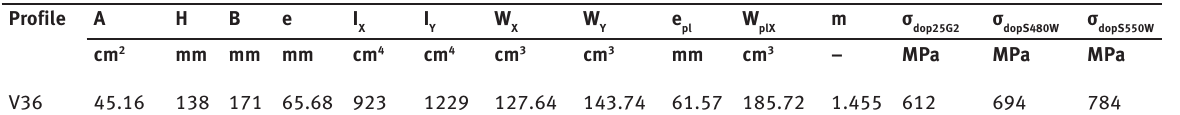
Table 3: Cross-sectional mechanical parameters of V36 profile